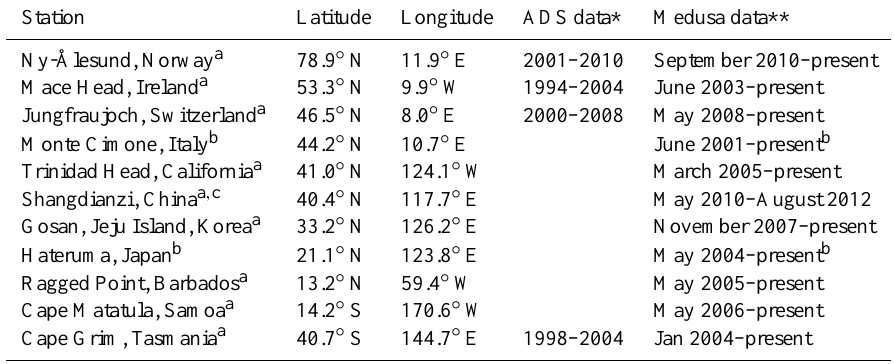
Table 1. Overview of the 11 measurement stations used in this study, their coordinates and periods for which data are available.